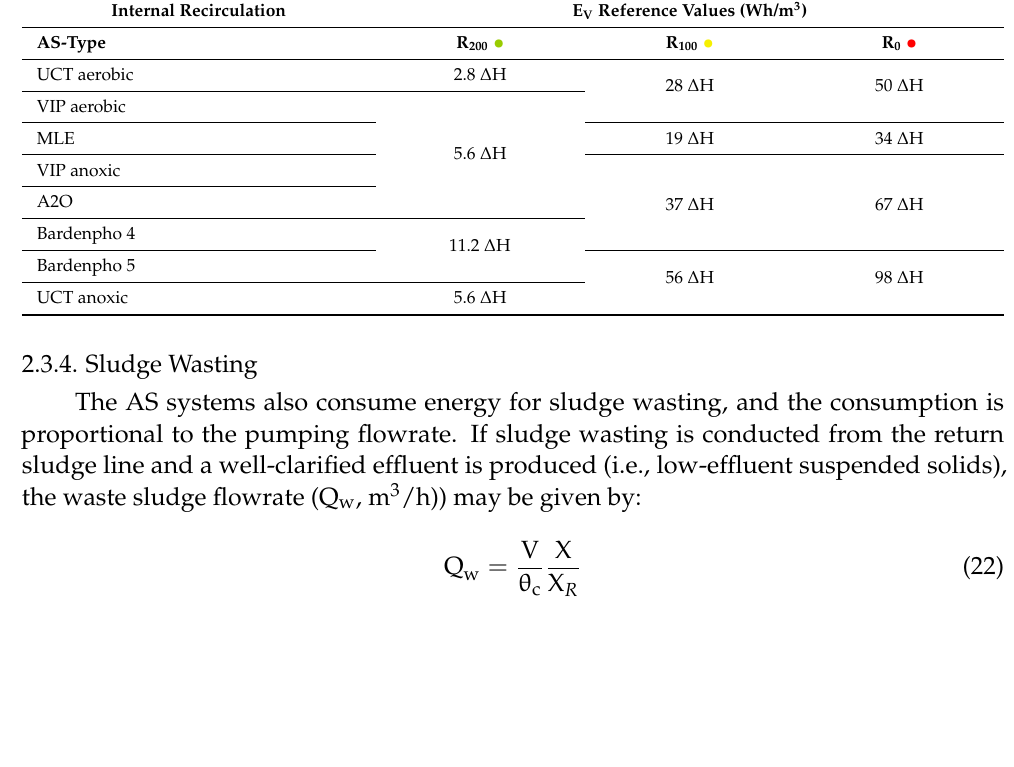
Table 10. The reference values of the energy consumption for the internal recirculation in AS systems. Internal